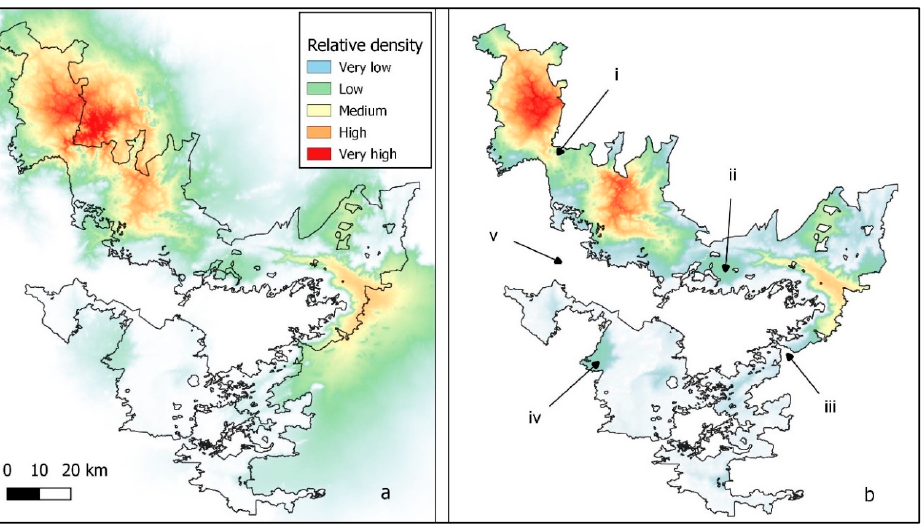
Figure 4. Elephant population core areas relative to slope with boundary completely open to elephant movement ( a ). Elephant population core areas relative to slope with boundary completely closed to elephant movement ( b ) with (i) and (iii) split core areas, (ii) and (iv) isolated populations, and (v) the severance of a major connection outside the NBR. Reserve boundaries were obtained from the